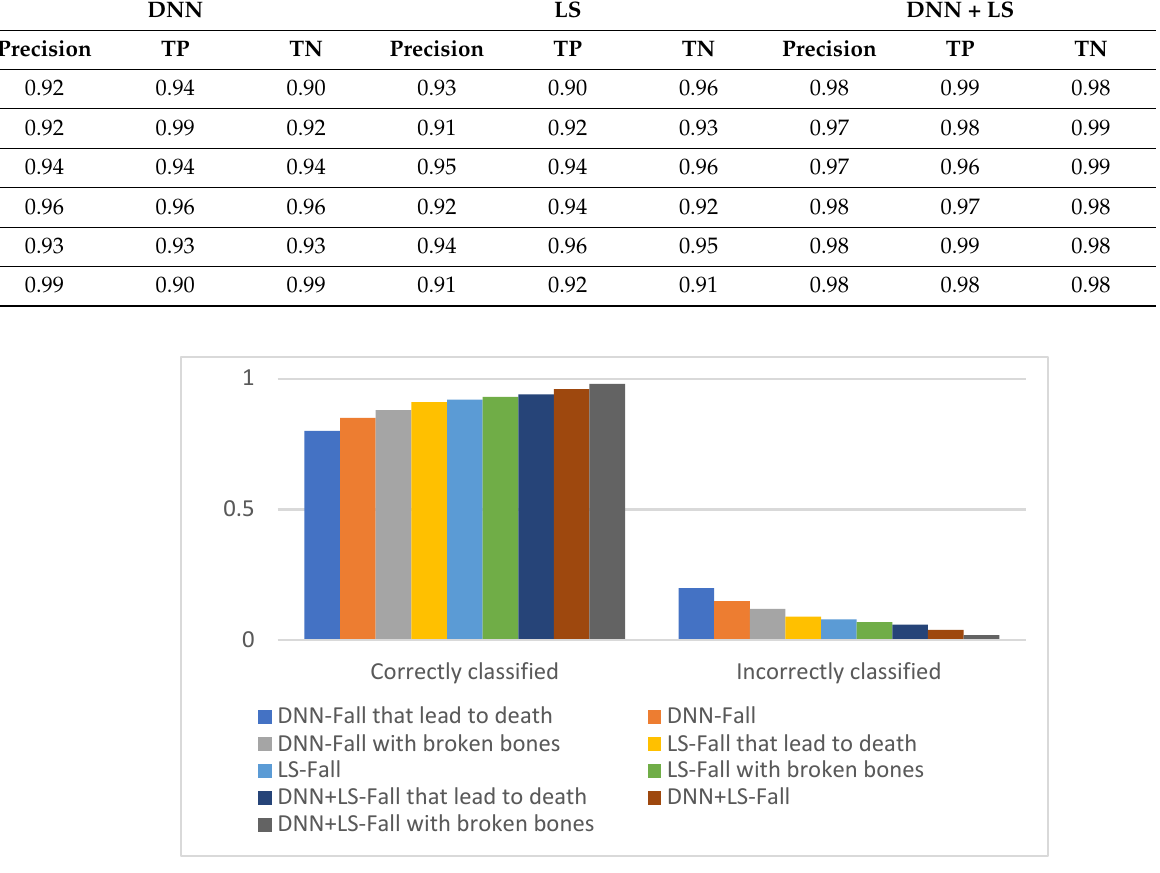
Figure 9. Correctly classified versus incorrectly-classified instances. Table 9. Statistics for using DNN model and C-Means with a long short memory for multi-risk pre- diction.